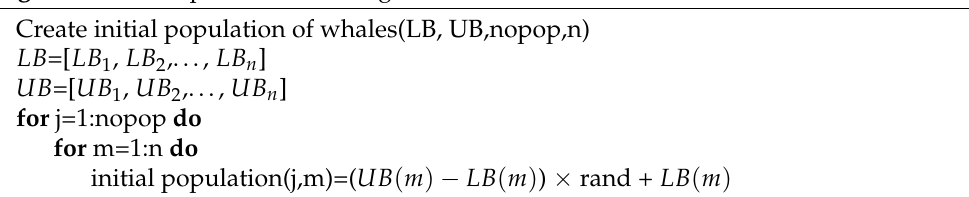
Figure 3. Bubble-net feeding strategy for whale. Algorithm 1 First phase of WOA